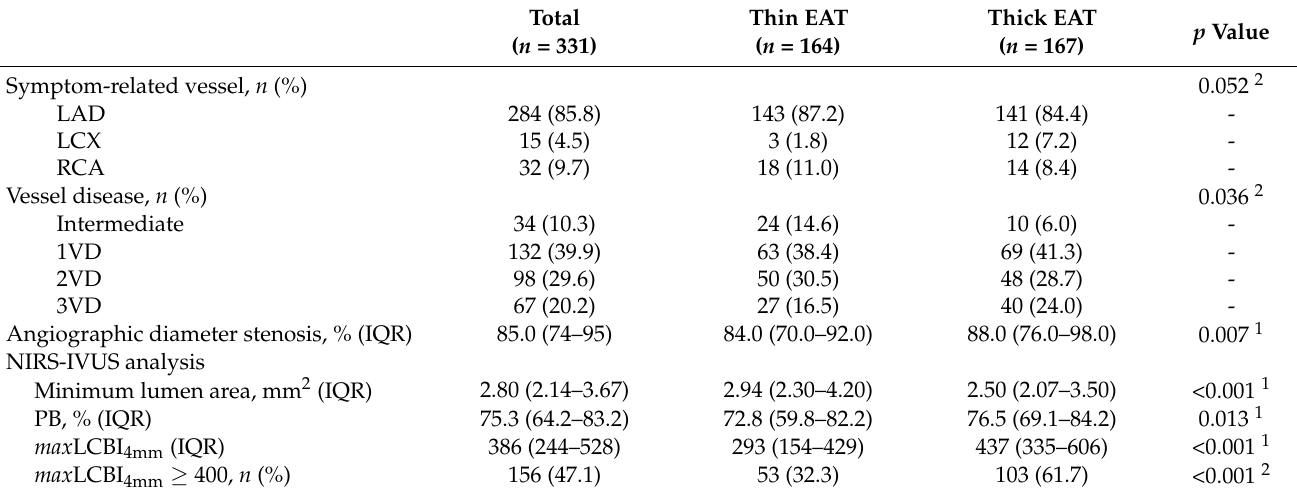
Table 2. Angiographic and NIRS-IVUS